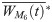
The thresholded matrix WM6(t)¯* representing the group M6.